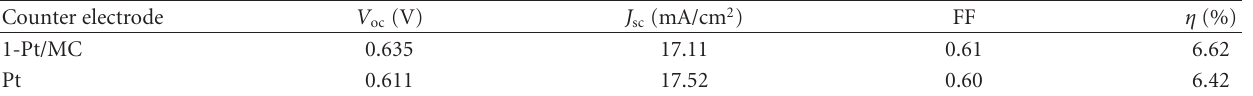
Table 3: The photovoltaic parameters of DSCs with 1-Pt/MC counter electrode and the conventional Pt counter electrode. Counter